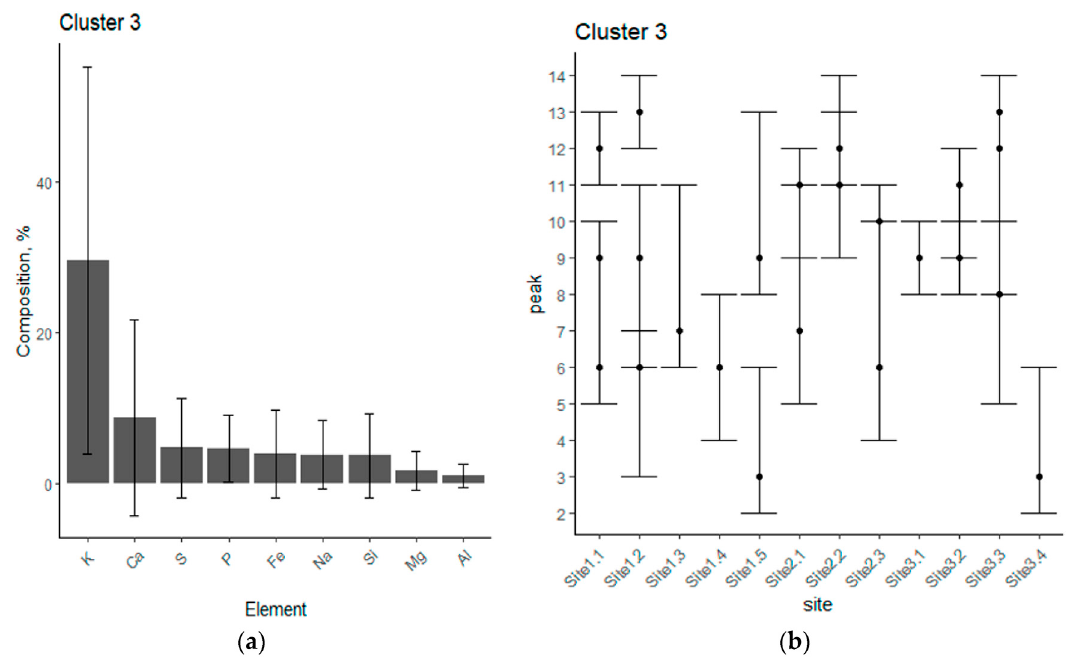
Figure 6. ( a ) Average chemical composition and standard deviation of the components in cluster 3; ( b ) extraction peak location and their windows of extraction for cluster 3 components. Cluster 4 is Ca dominated (ca. 70%) and is extracted at low acid concentrations (component